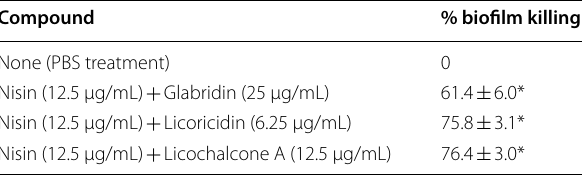
*Significantly different ( p < 0.01) from control biofilms treated with PBS Table 5 Effects of nisin/glabridin, nisin/licoricidin, and nisin/licochalcone A on the viability of oral epithelial cells, gingival fibroblasts, and stem cells of the apical papilla (SCAP) after a 2-h contact